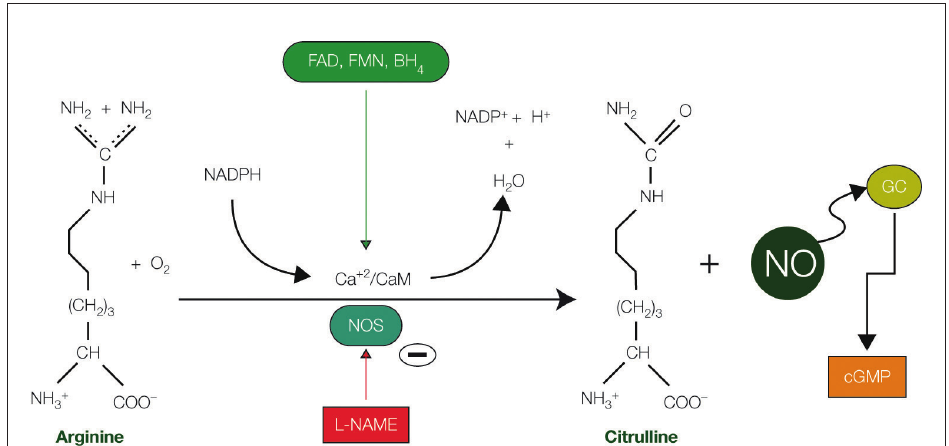
Figure 1 | Nitric oxide synthesis. Diagram showing the synthetic pathway responsible for nitric oxide (NO) production from arginine and O and catalyzed by the enzyme nitric oxide synthase (NOS). Cofactors include reduced nicotinamide 2 adenine dinucleotide phosphate (NADPH), tetrahydrobiopterin (BH ), flavin mononucleotide (FMN), and flavin adenine 4 dinucleotide (FAD). Synthesis of NO can be pharmacologically abolished by the action of the N-omega-nitro-L-arginine methyl ester (L-NAME), an inhibitor of both nNOS and eNOS. Abbreviations: Ca + 2 /CaM: Calcium/calmodulin; cGMP: cyclic guanosine monophosphate; GC: guanylate cyclase; PKG: protein kinase